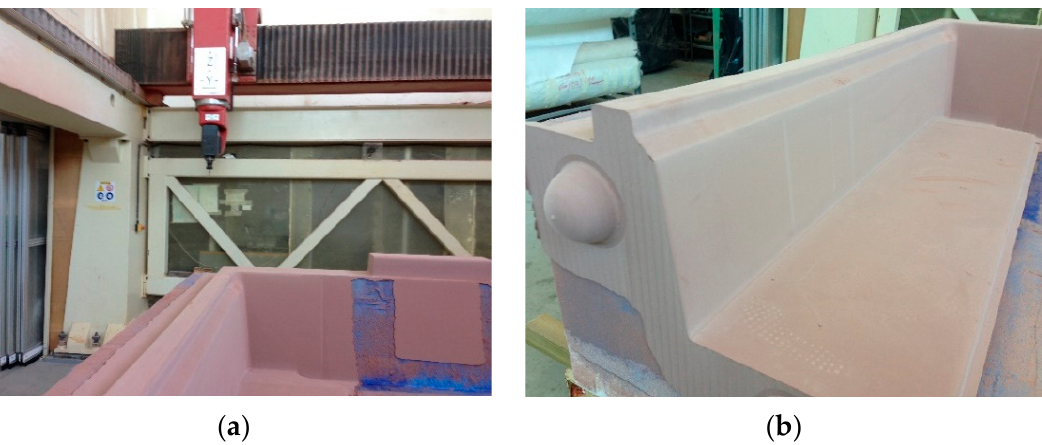
Figure 12. Large ‐ scale mould finishing: ( a ) rough milling to remove exceeding external clay; ( b ) Figure 12. Large-scale mould finishing: ( a ) rough milling to remove exceeding external clay; accurate milling for surface finishing. ( b ) accurate milling for surface